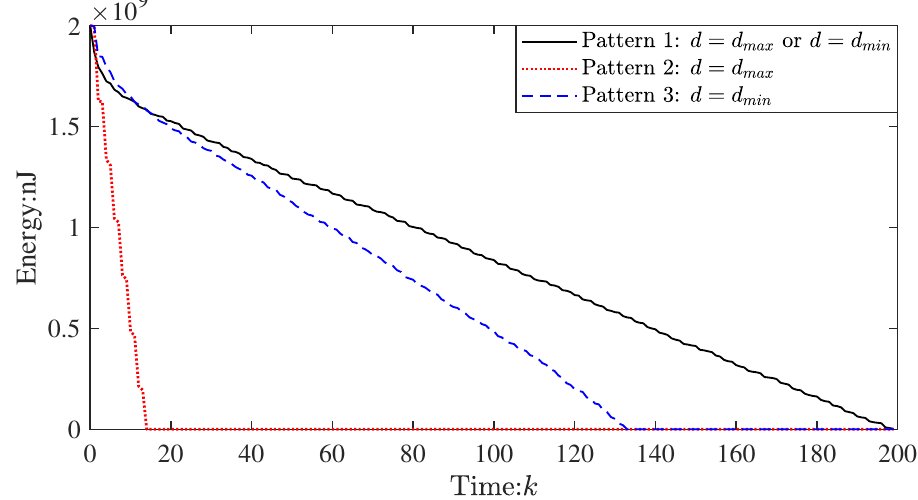
Figure 6. The energy consumption change of the node that first runs out of energy in the three patterns when δ = 0.8.